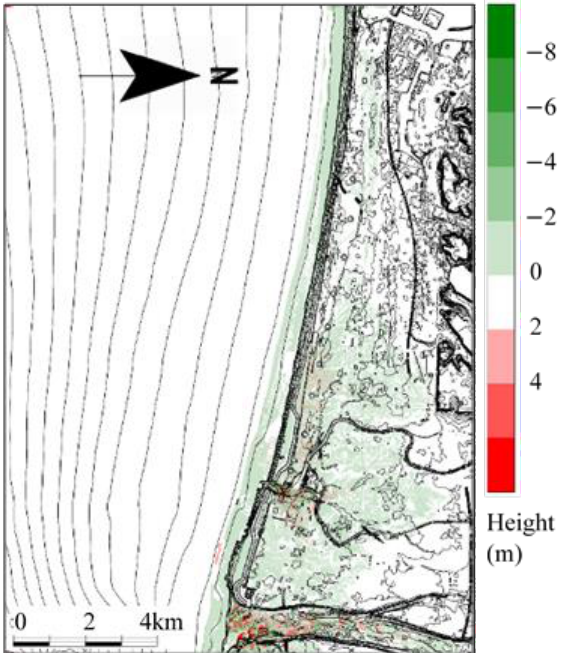
Figure 18. Topography change output 33 min after the start of calculation (after structural developments).